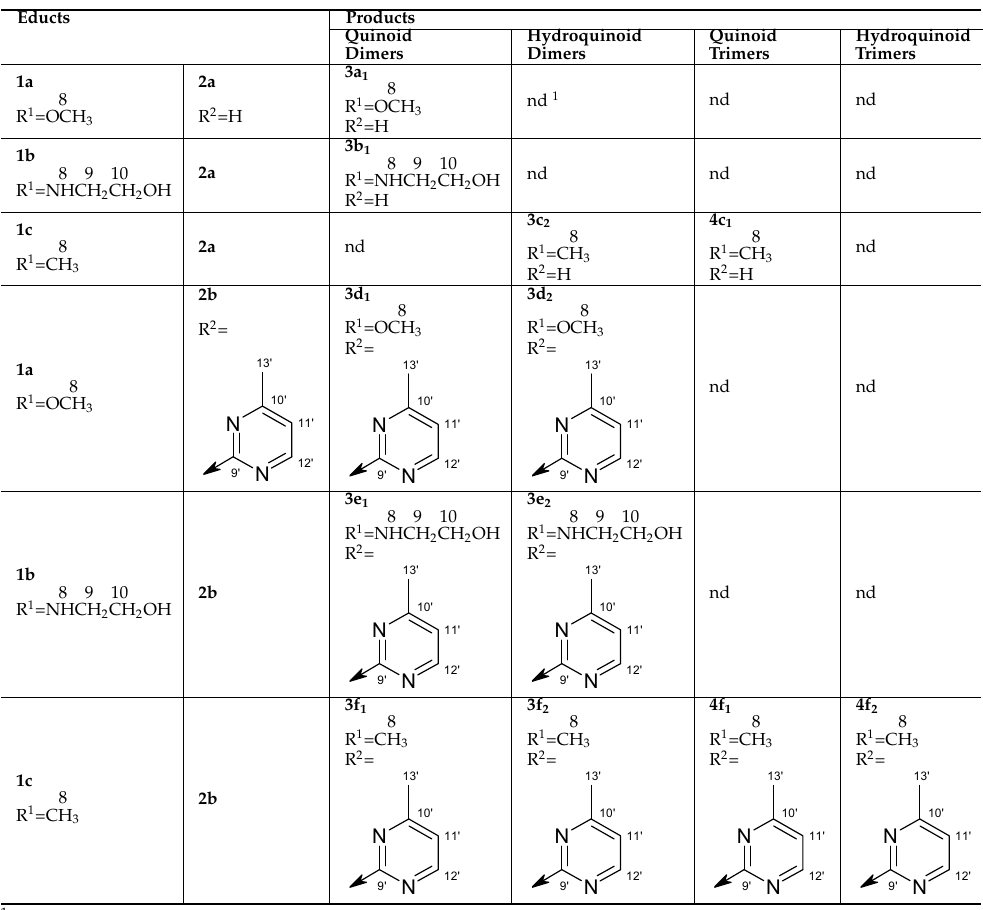
1 not detected by the measurements used. After separation of 3a 1 and 3b 1 by solid phase extraction, LC/MS analyses in negative and positive mode showed molecular masses of these products attributed to the formation of heteromolecular hybrid dimers each consisting of a structural part of a 2,5-dihy- droxybenzene derivative ( 1a or 1b ) coupled to 2a accompanied by the loss of four hydro- gen atoms. These couplings were confirmed by the presence of characteristic signals for 1a or 1b and for 2a in the 1 H NMR spectra of 3a 1 and 3b 1 as well as by the presence of all carbons of 1a or 1b and of 2a in the 13 C − NMR spectra of the products, but two signals in the range of 180 ppm indicated a quinoid character of these products. The number of CH